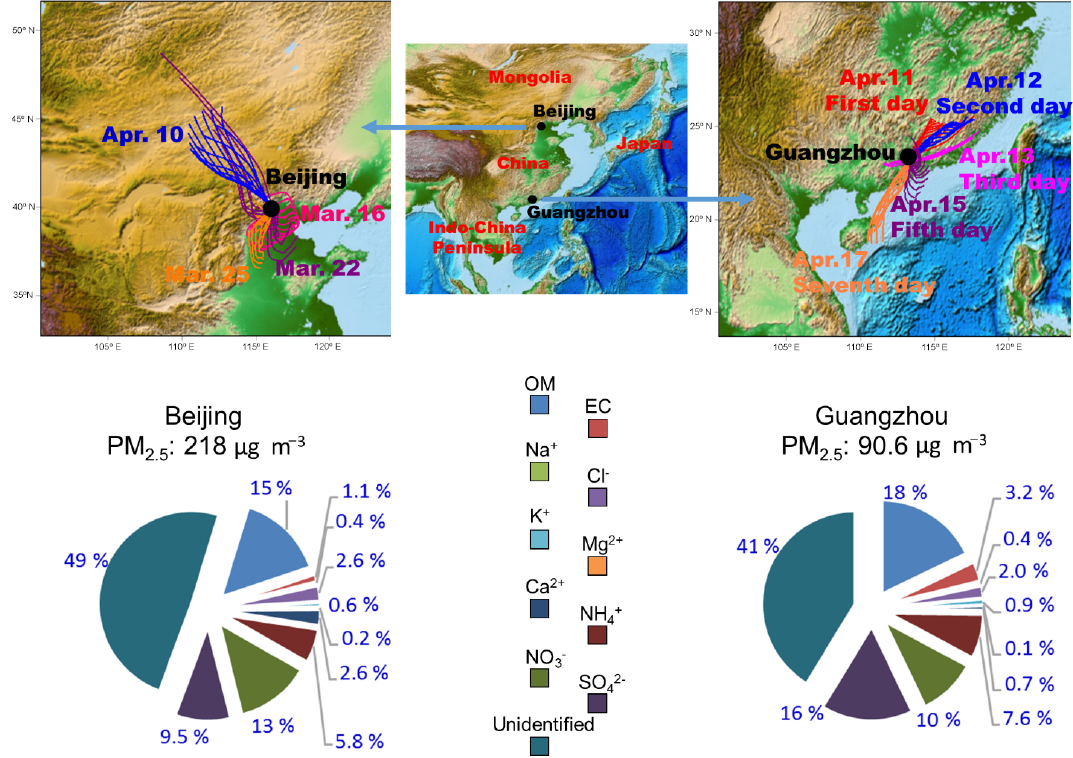
Figure 1. Geographic locations of Beijing and Guangzhou as well as their PM 2 . 5 chemical compositions. Air mass back trajectories within 24h (run every 2h from the end of sampling) for the selected samples are modeled at 100m above ground level by Air Resources Laboratory, National Oceanic and Atmospheric Administration (Hybrid Single Particle Lagrangian Integrated Trajectory